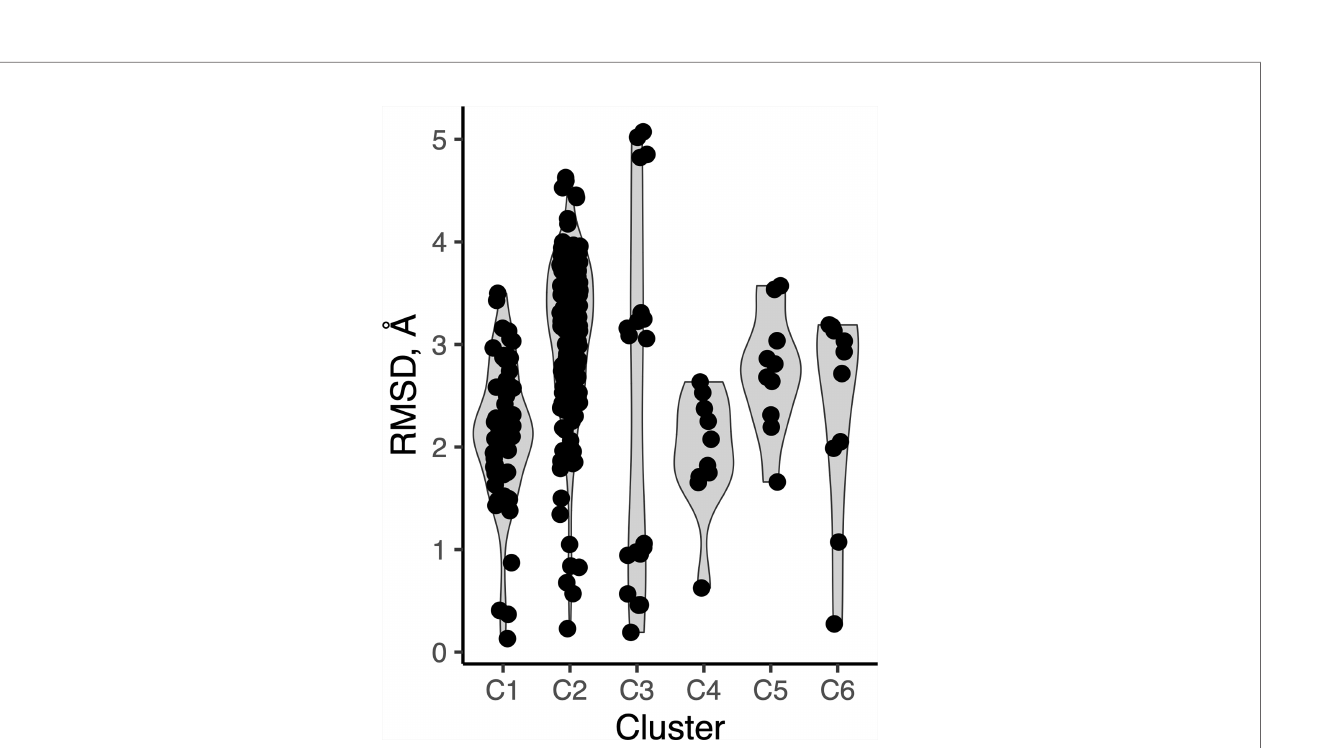
FIGURE 9 | Peptide conformational variability in antibody-peptide complexes. Clusters of antibody-bound peptide structures (C1-C6), each with common epitope sequences, were used to calculate pairwise backbone root-mean-square distance between the observed peptide conformations within each set. Each point represents an RMSD value between two peptide